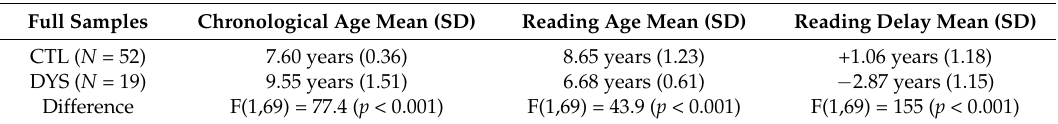
Table 1. Characteristics of the full samples of children with dyslexia (“DYS”) and control children (“CTL”).